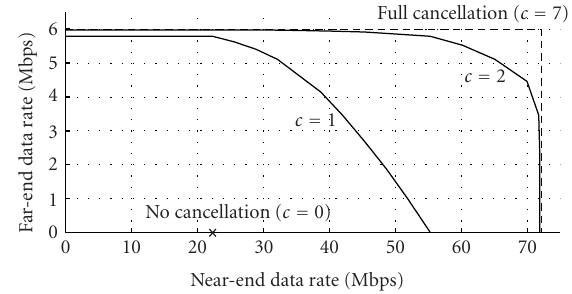
Figure 8: Achievable rate regions versus complexity (simple joint selection algorithm).